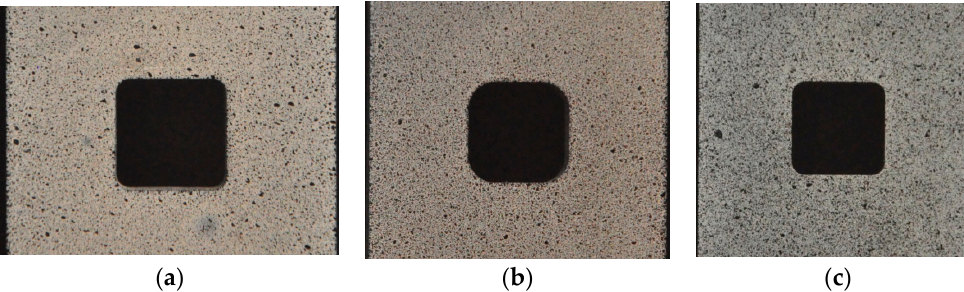
Figure 4. Mid-side parts of samples with rectangular holes coated by speckle pattern: ( a ) S355MC, radius 2 mm; ( b ) S355MC, radius 4 mm; and ( c ) 41Cr4 radius 2 mm.